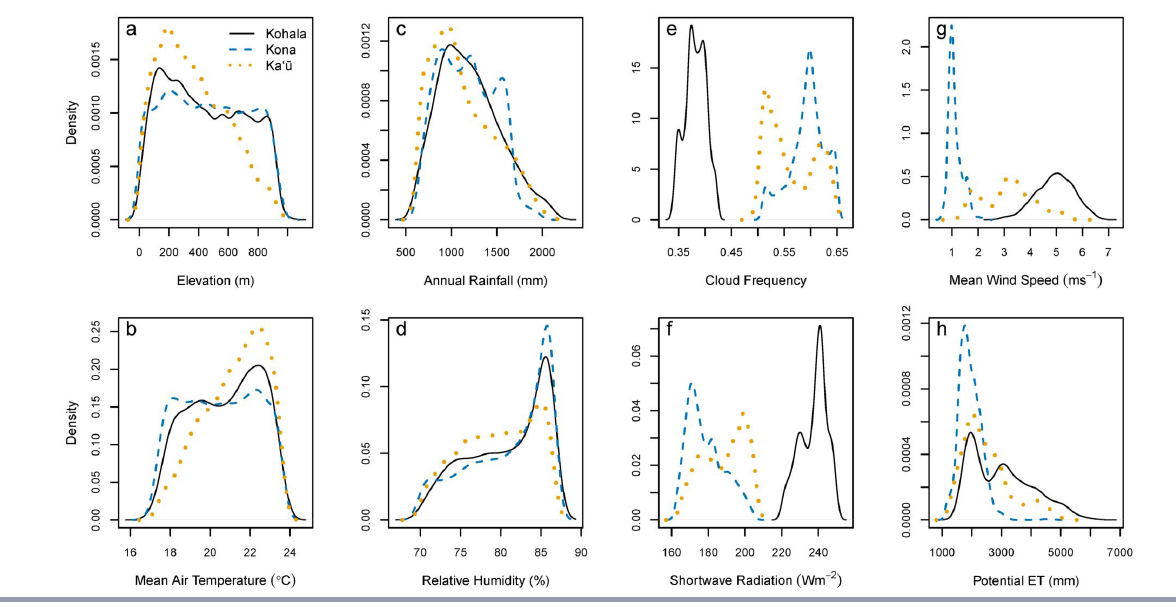
Fig. 2 . Kernel density estimates for the Kohala, Kona, and Ka ʻū field systems for (a) elevation (m), and mean annual values of (b) air temperature (°C), (c) rainfall (mm), (d) relative humidity (%), (e) cloud frequency, (f) incident shortwave radiation (Wm-2), (g) wind speed (ms-1), and (h) Penman-Monteith potential evapotranspiration